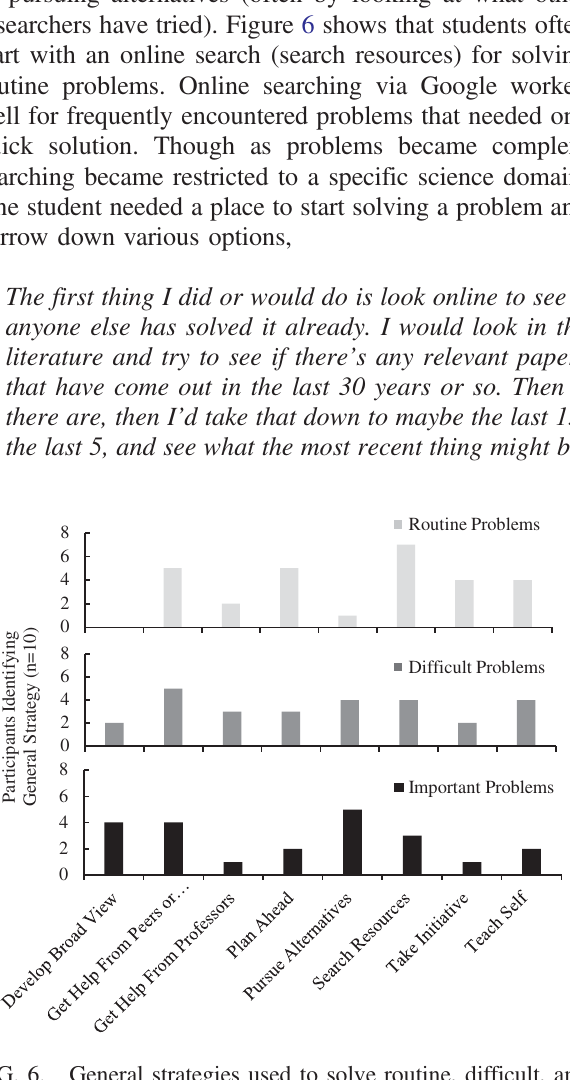
FIG. 6. General strategies used to solve routine, difficult, and important problems in Ph.D.-level